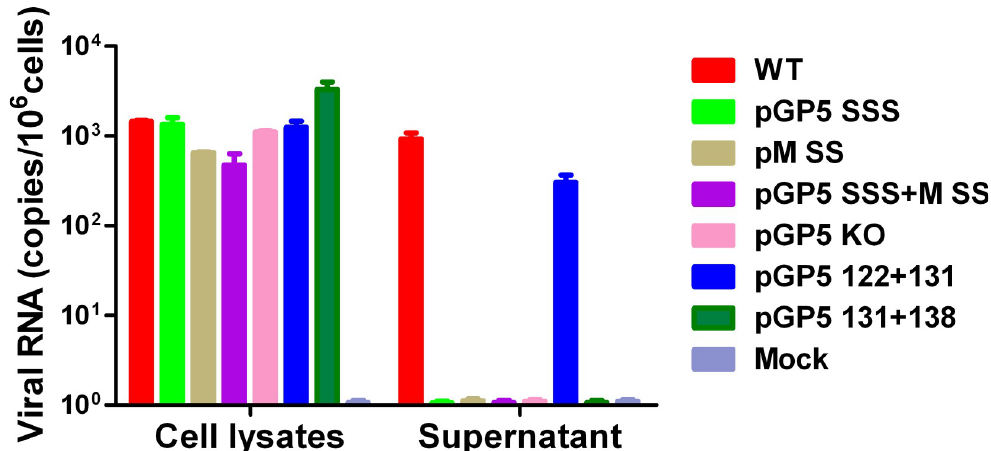
Fig 4. Palmitoylation of GP5 and M is required for release of virus particles from transfected cells. Quantification of viral genomes present in cellular lysates or released into the supernatant of BHK cells transfected with full-length PRRSV plasmids as indicated. GP5 KO is a mutant where expression of GP5 was abrogated by mutation of its start codon. 24 hours post-transfection, viral RNA was isolated from cleared and benzonase-treated culture supernatants and from cell lysates and reverse transcribed into cDNA. Q-PCR was done with primers that amplify a fragment of the viral GP3 gene. Full-length plasmid of an infectious wild-type clone was as used as a standard to estimate the number of gene copies. Results from three independent transfections are shown as number of viral RNA (mean including standard deviation) present in or released into the supernatant of 1x10 6 transfected